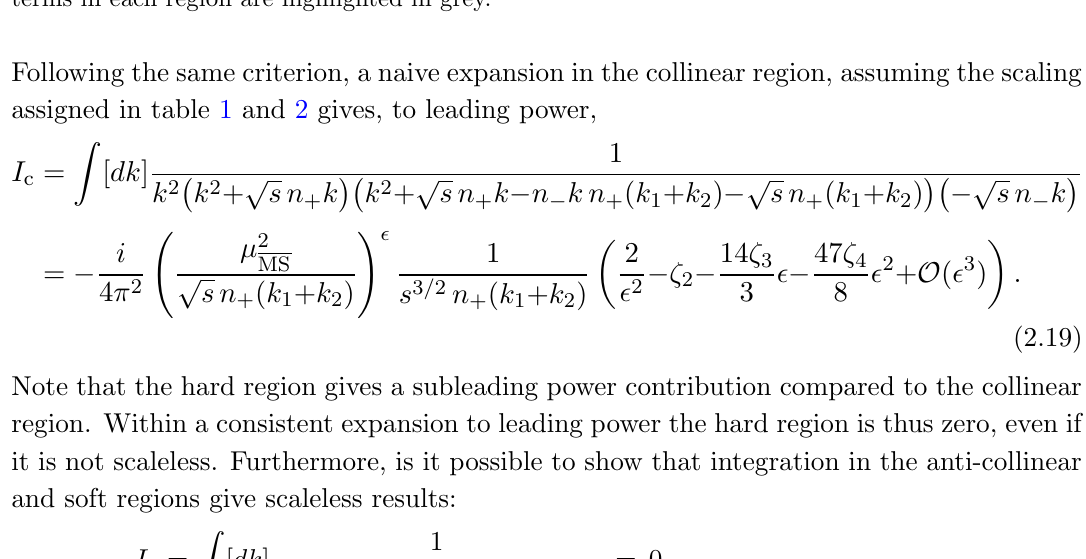
Table 2 . Scaling associated with the terms in the propagators D c , as de(cid:12)ned in eq. (2.17). Leading terms in each region are highlighted in